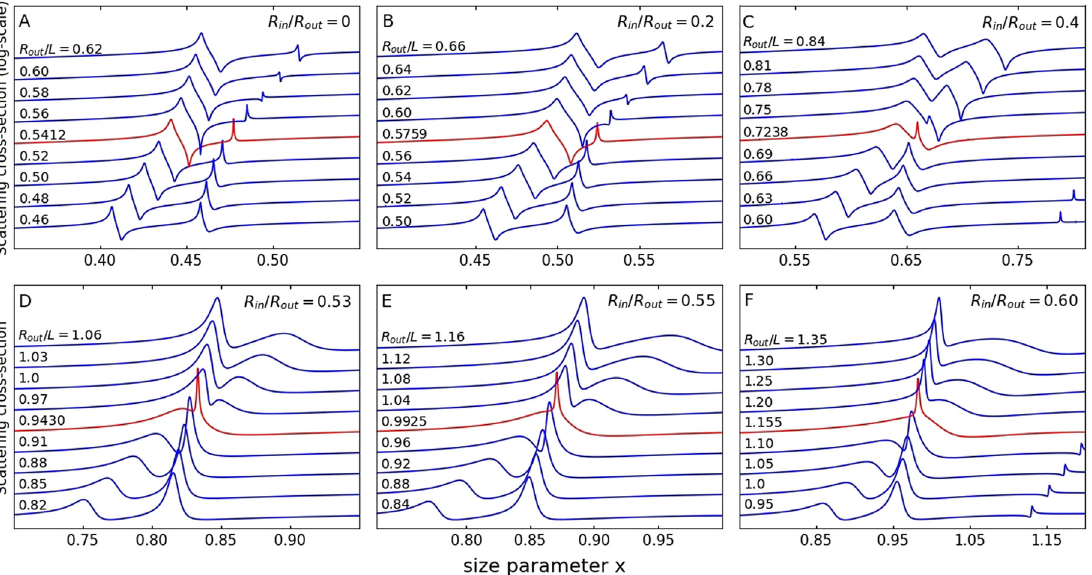
Figure 2: Spectra of the normalized SCS (for harmonic n = 1) for cylindrical and ring dielectric resonators as a function of their aspect ratio R out / L